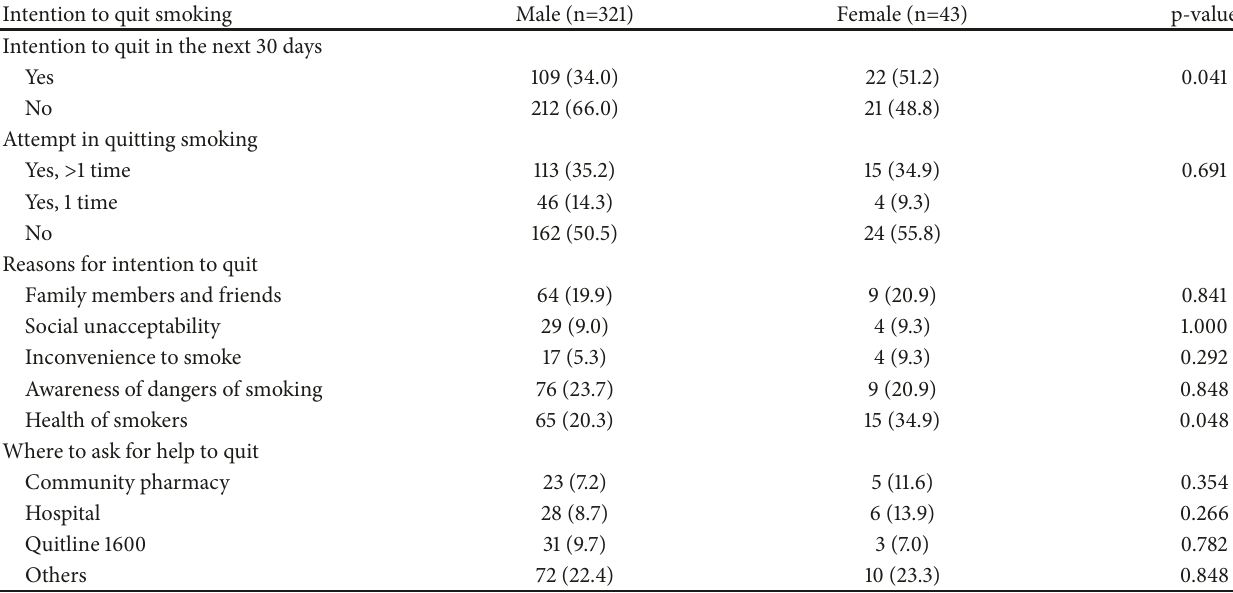
Table 4: Differences of intention to quit smoking between males and females